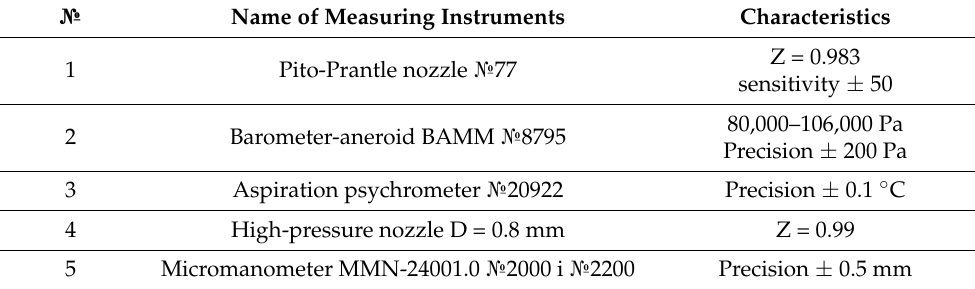
Table 1. Devices for research and their technical